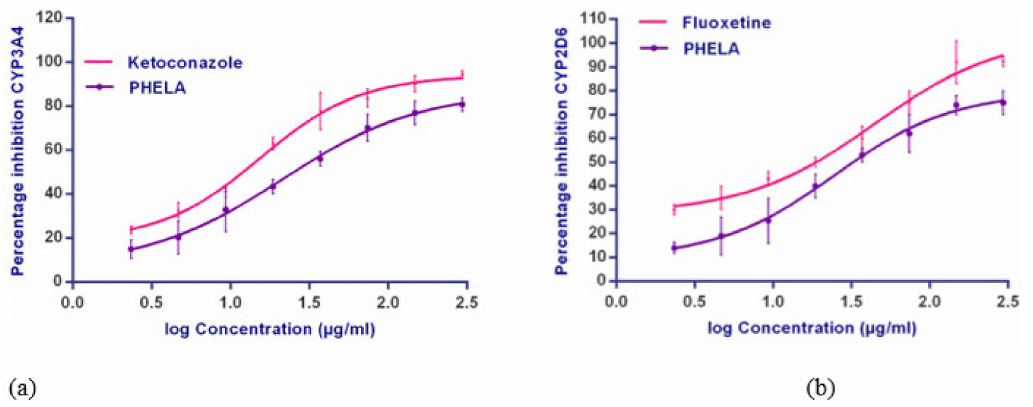
Figure 3. CYP3A4 ( a ) and CYP2D6 ( b ) inhibitory effect of PHELA ® extract and standard